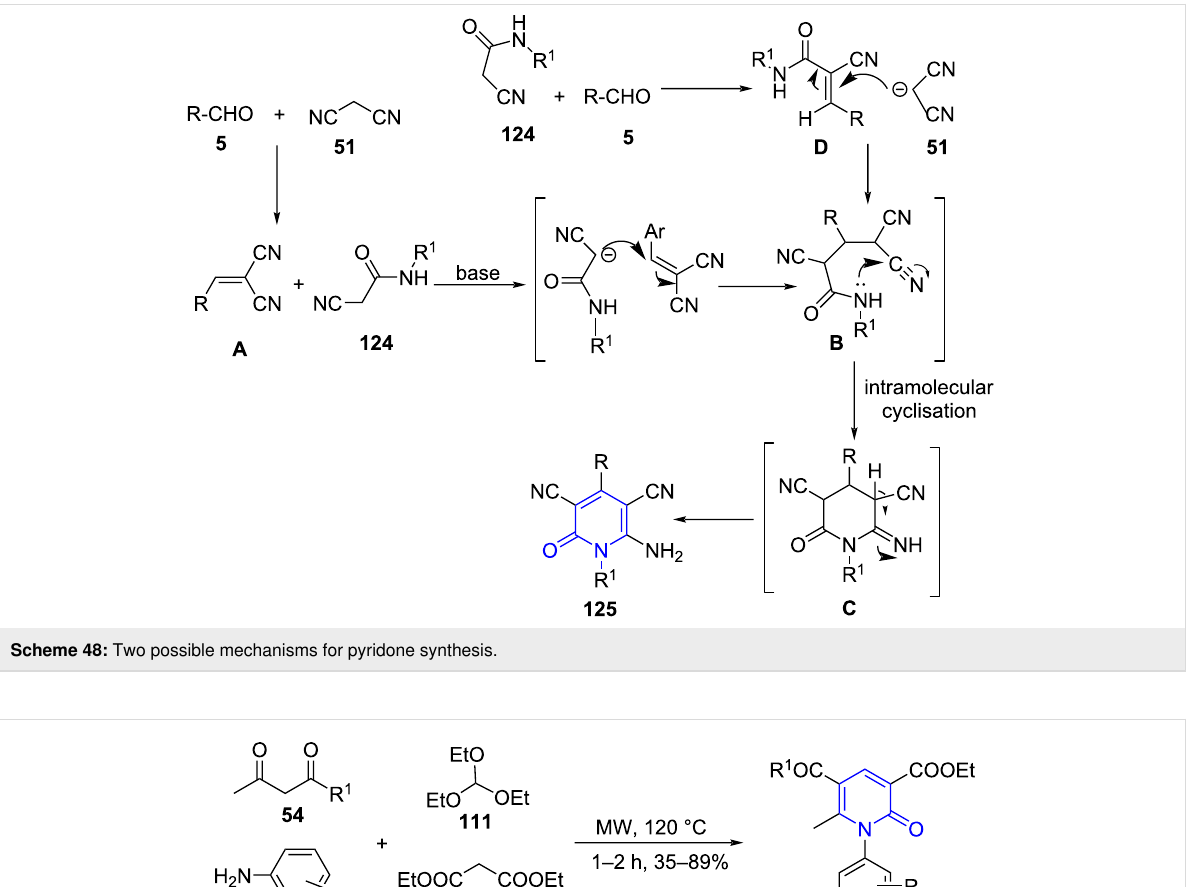
Scheme 49: Synthesis of pyridone